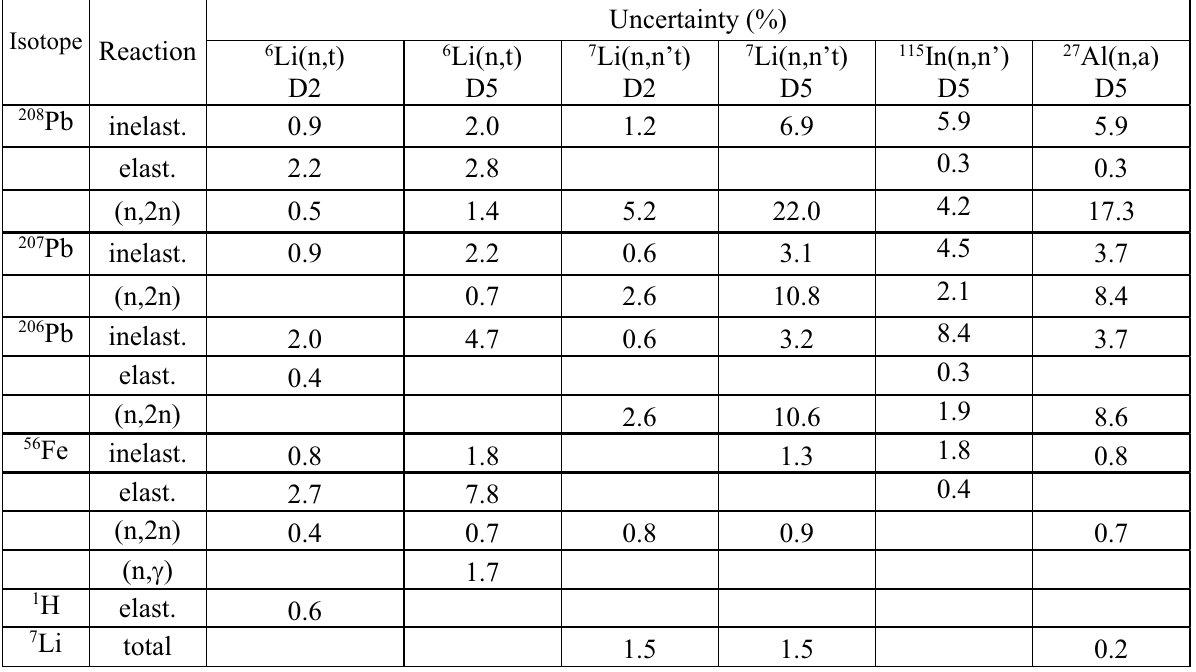
Table I. Main contributors to uncertainty in the calculated detector reaction rates due to uncertainties in neutron cross sections. Ten largest contributors are listed for each detector reaction ( SUSD3D preliminary results based on the TORT neutron fluxes (D2=7.7 cm, D5=46